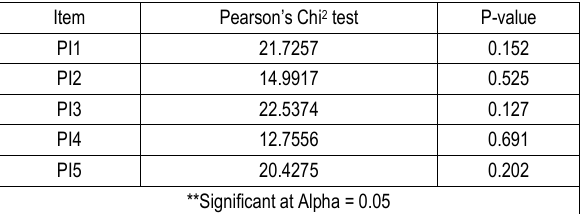
Table 10. Association between age and purchase